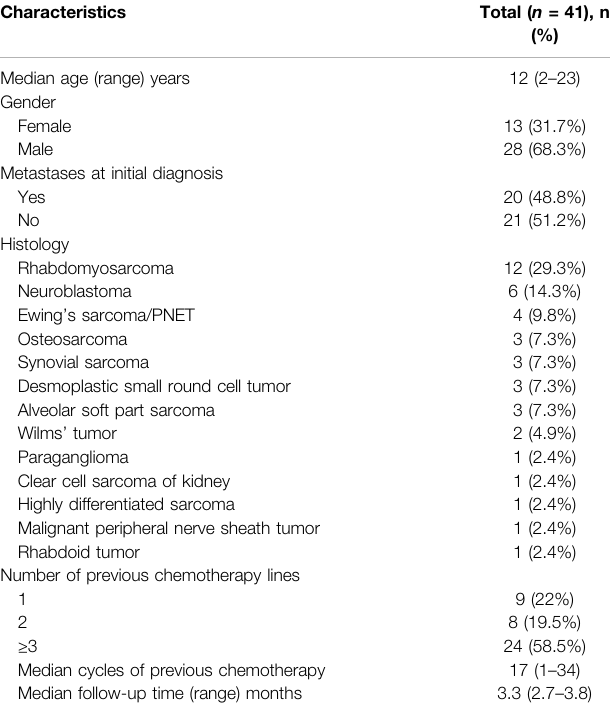
TABLE 1 | Baseline characteristics of the